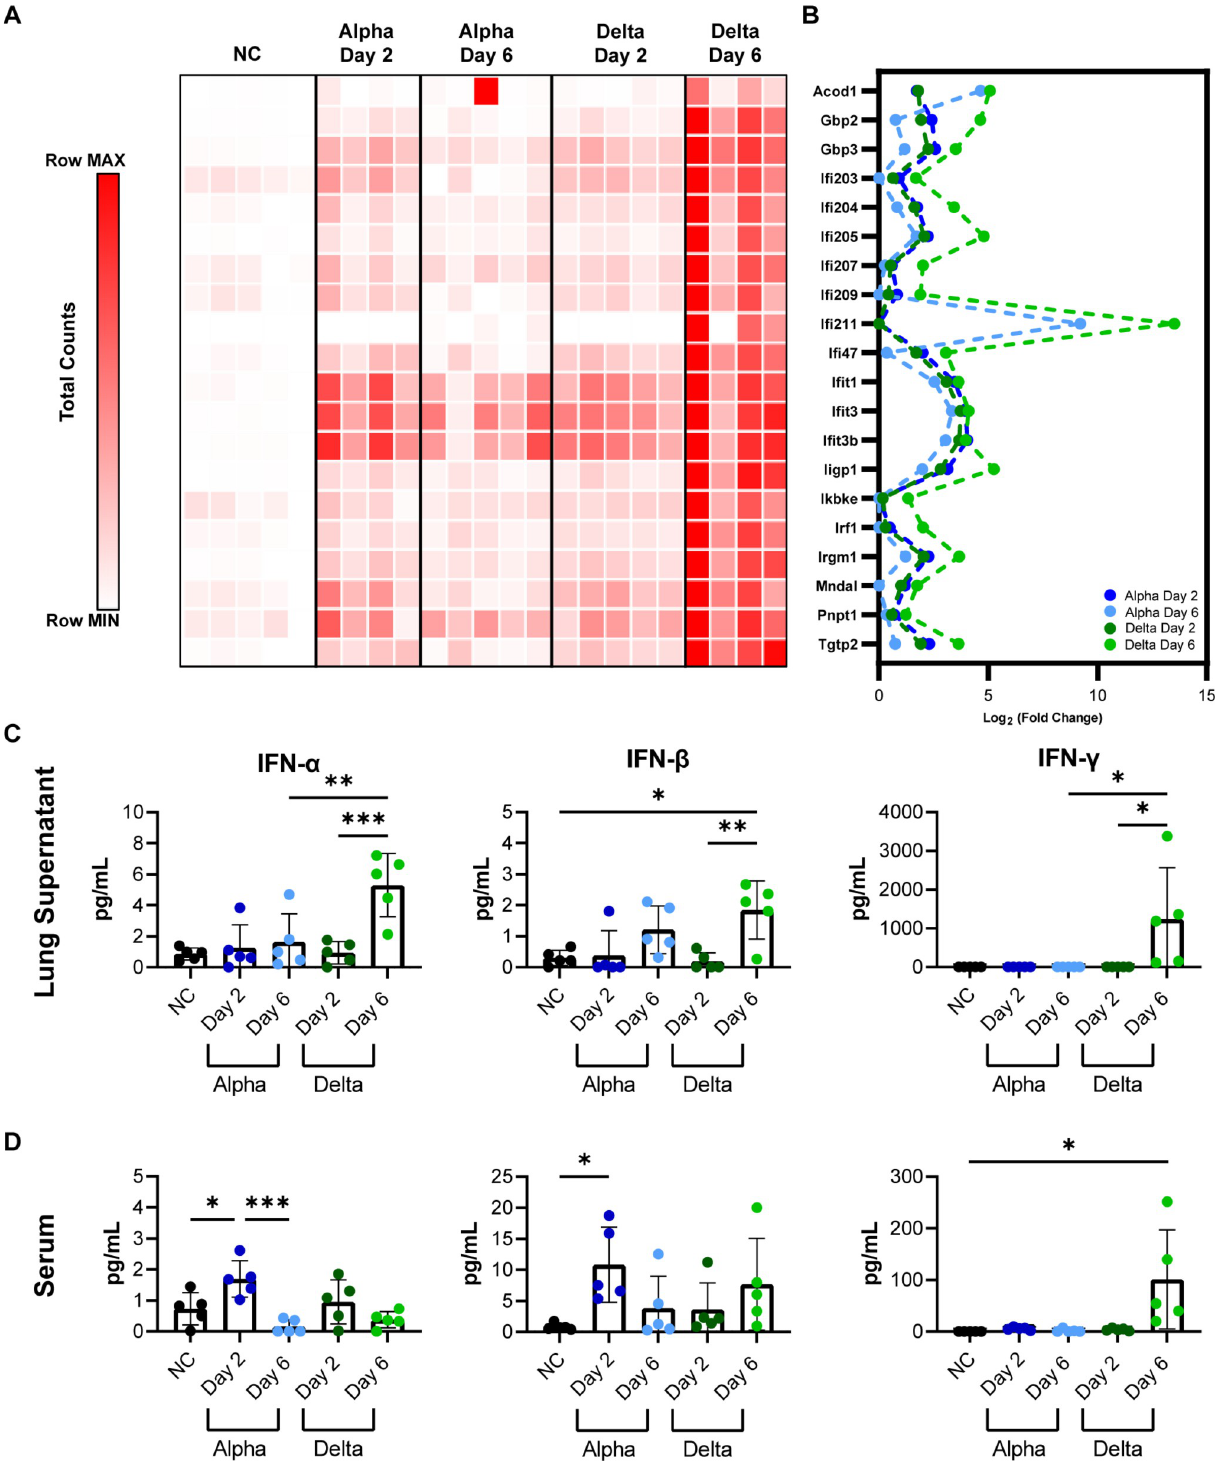
Fig 8. Analysis of interferon dependent gene expression and production of type I and type II interferon in lungs and serum of K18-hACE2-mice. Total RNA counts per interferon dependent gene are shown per each mouse, time-point, and variant challenge group (A). Each square represents the total RNA counts per gene from one mouse. Interferon dependent genes are shown with relative fold change plotted (B). Interferon alpha, beta, and gamma production in lung supernatant (C) and serum (D) of K18-hACE2-mice. (n = 5).